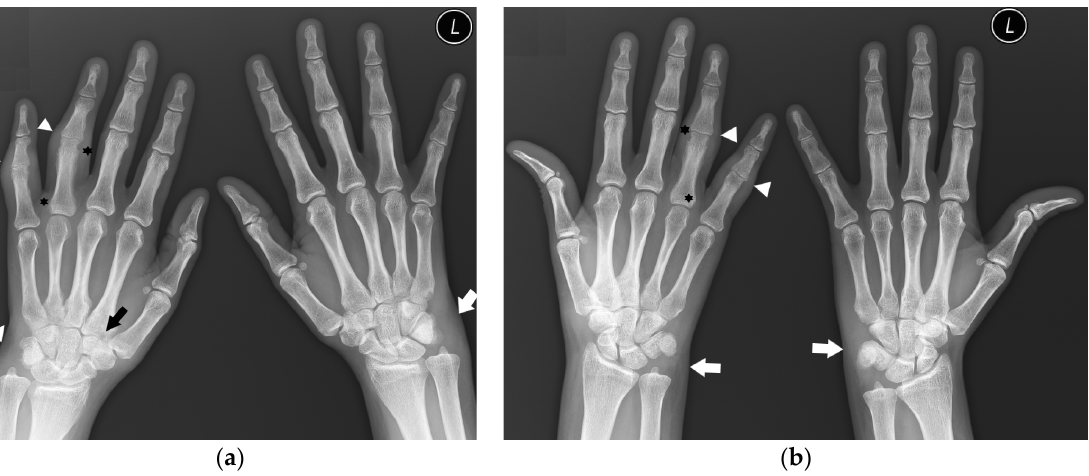
Figure 8. A 31-year-old female with PsA. PA ( a ) and Nørgaard radiographs ( b ) of bilateral hands. Note the sparring of the DIP joints. There is soft tissue swelling and contracture at the level of the fourth and fifth digits on the PIP joints of the right hand (arrowheads). Note the soft tissue swelling around both wrists, especially on the ulnar side (white arrows). There are erosions at the base and head of the right fourth digit proximal phalanx with discrete proliferative bone changes (stars). Note the narrowing of the left fourth PIP and right second CMC joint spaces with bone cysts at the base of the right second MC bone (black arrow).